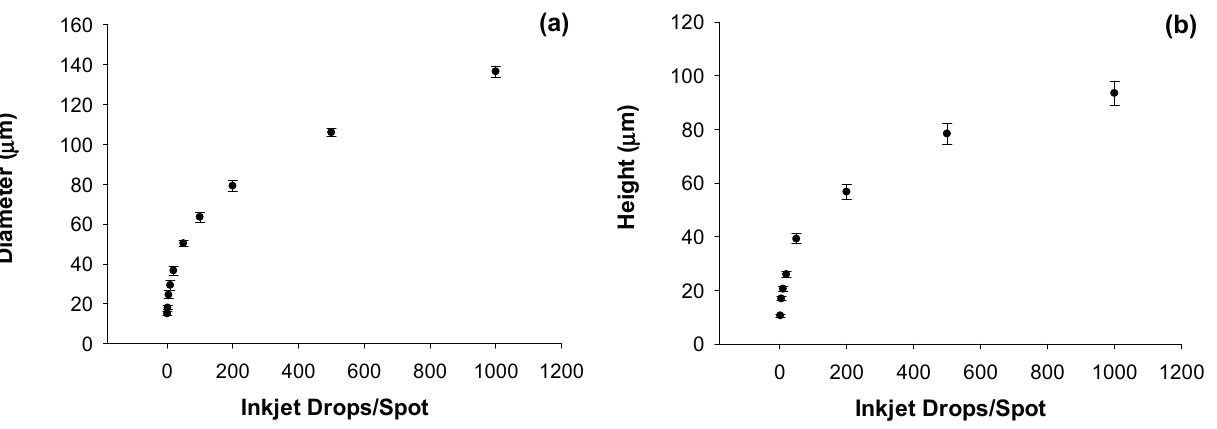
Figure 4. ( a ) Individual particle diameters as measured from a series of arrays of increasing numbers of inkjet microdrops/spot using scanning electron microscopy; ( b ) Measured particle heights measured from a series of arrays of increasing particle height as measured using scanning electron microscopy at oblique incidence angles. Error bars represent the standard deviation of multiple measurements (n) with n varying from 3 to